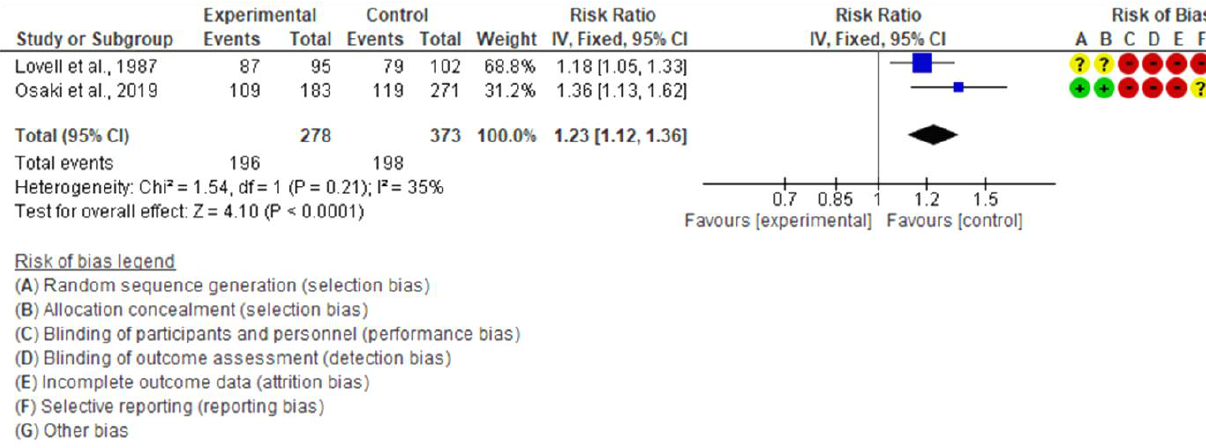
Figure 15. Meta-analysis for the effect of MCH handbook interventions vs. standard care on support from family during pregnancy [20,22]. Red color with a − symbol means a high risk of bias, yellow color with a ? symbol means an unclear risk of bias, and green color with a + symbol means a low risk of